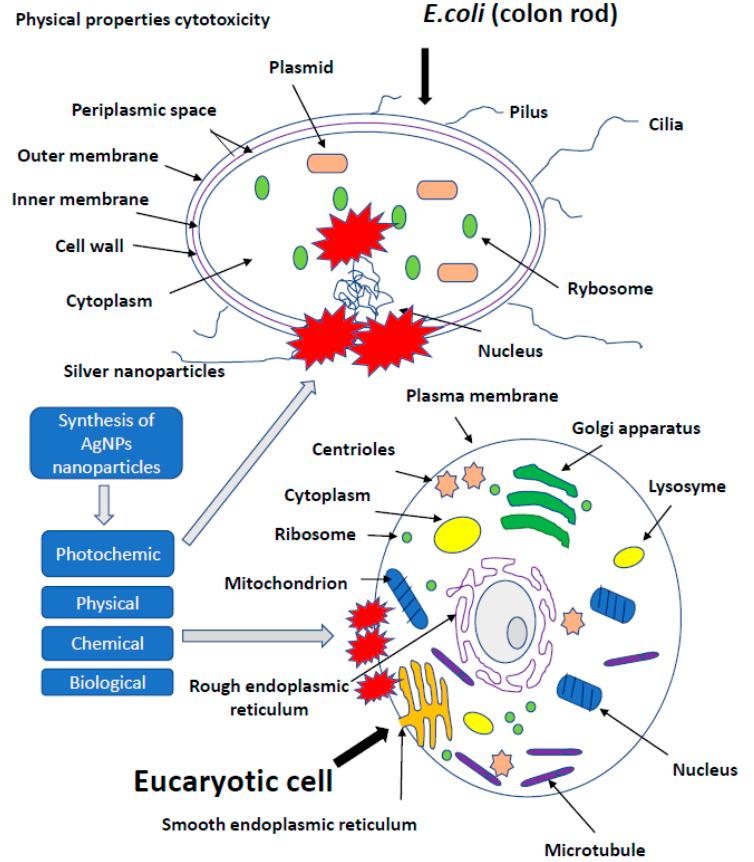
Figure 3. The effect of silver on more developed organism. It is noted that clinical symptoms, such as wound exudate, lower the cytotoxicity of AgNPs, and in this case, the high concentration of proteins in the exudate may neutralize the toxicity of nanosilver to neighbouring tissues.